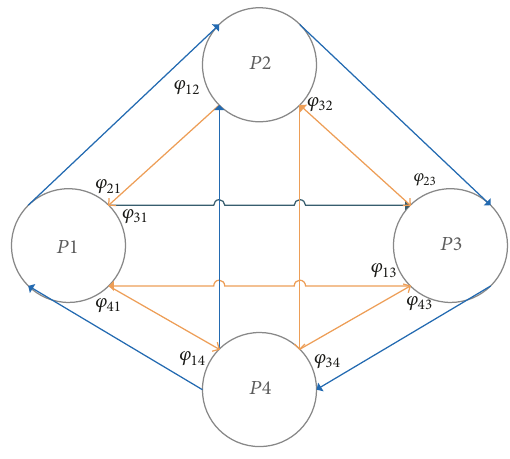
Figure 4: Four-state Markov